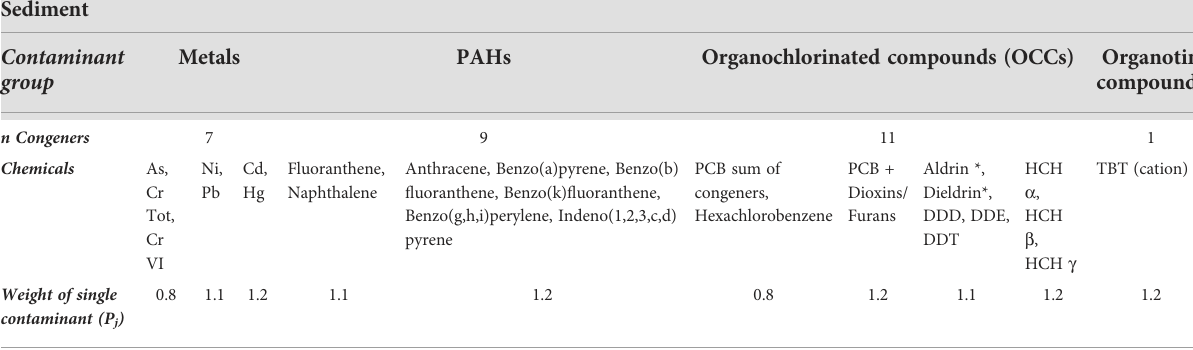
TABLE 2 Contaminants monitored in sediment and weight of single contaminant.